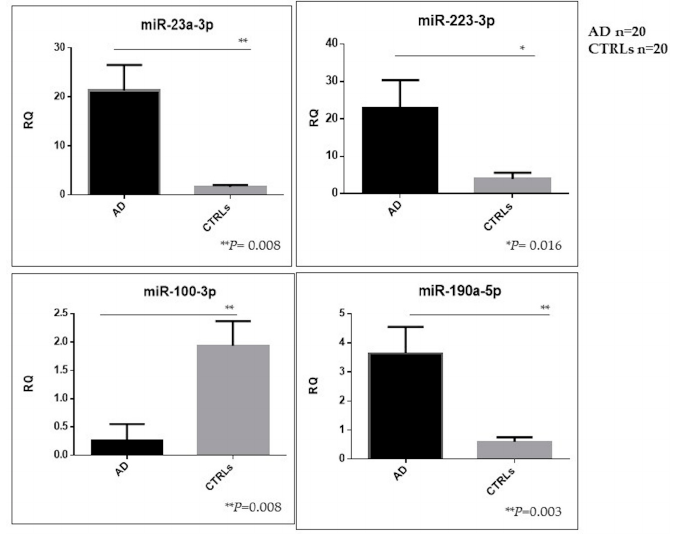
Figure 7. Relative expression of best dysregulated miRNAs tested in NDEVs from the remaining 20 AD patients and 20 CTRLs (miR-23a-3p ** p =0.008; miR223-3 * p = 0.016; miR-190a-5p ** p = 0.003; miR-100-3p ** p = 0.008).